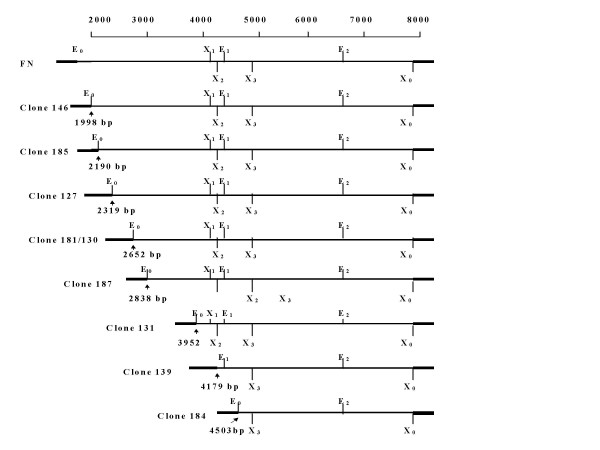
Alignment of nine positive clones' fragments. Alignment of nine positive clones' fragments from EcoR I and Xho I digestion and comparison to fibronectin. E0: EcoR I site of polylinker; E1: EcoR I site in fibronectin DNA sequence at position 4150; E2: EcoR I site in fibronectin DNA sequence at position 6680; X0: Xho I site of polylinker; X1: Xho I site in fibronectin DNA sequence at position 4062; X2: Xho I site in fibronectin DNA sequence at position 4122; X3: Xho I site in fibronectin DNA sequence at position 4918. All nine clones overlapped from the poly(A). The shortest clone 184 spanned the sequence from the poly(A) end to 4503 bp of fibronectin; the longest clone146 spanned from poly(A) end to 1998 bp of fibronectin.